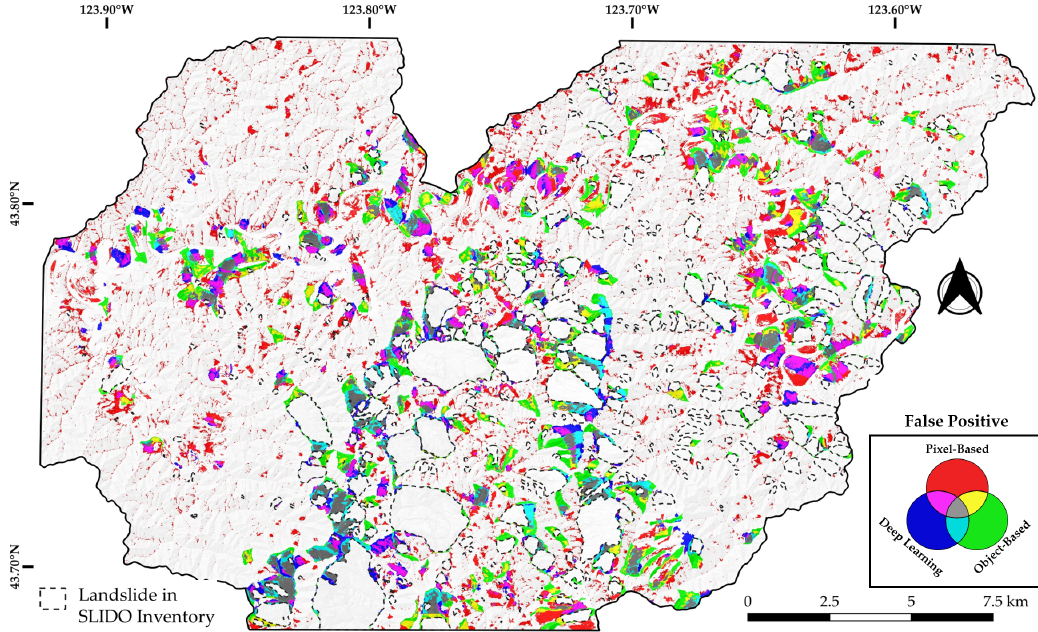
Figure 9. False positive predictions of all the three machine learning methods (i.e., pixel-based with RF, object-based with ANN and U-Net with ResNet34 backbone) on testing area. As described by the legend in the bottom-right, the primary colors represents the false positive prediction by only one method, while the secondary colors represents the false positive prediction by the combination of two methods. Gray coloured areas are false positive prediction by all the three methods. The map is in UTM Zone 10N with WGS 84 datum